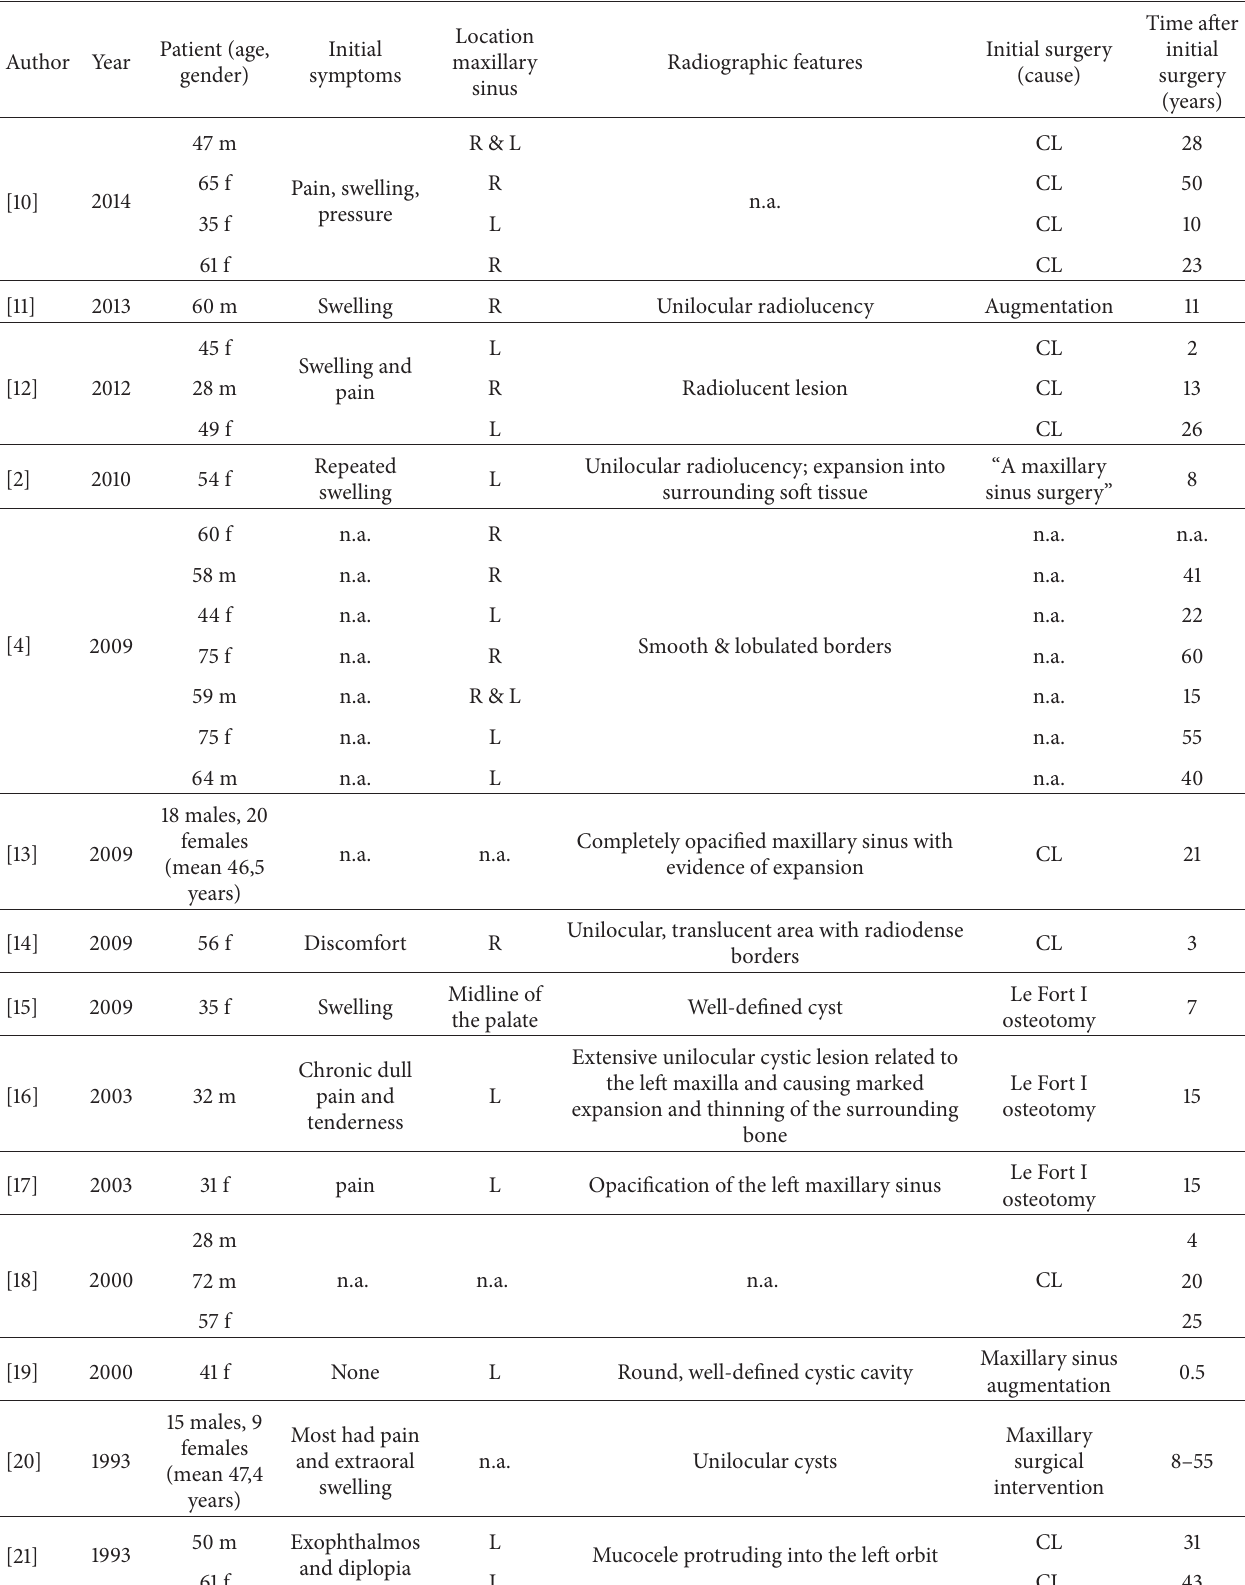
Table 1: Overview of clinicopathological features of PMCs obtained from the